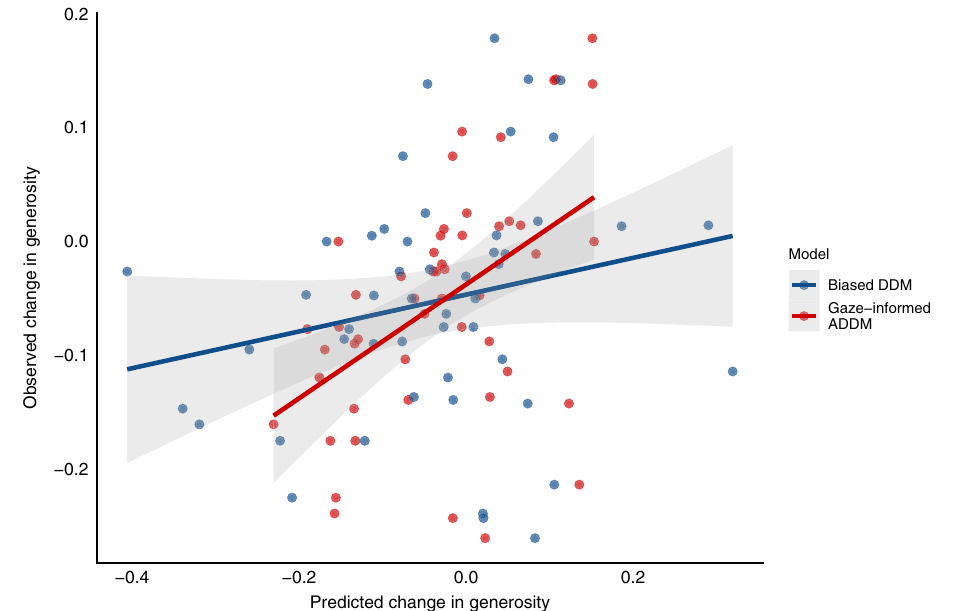
Fig. 6 Model comparison. Comparison between the gaze-informed ADDM and the biased DDM in their predictive accuracy of changes in generosity under time pressure. Each point represents a subject ( N = 50), and points on the dashed line indicate perfect prediction of the observed data, coloured by model. Source data are provided as a Source Data fi